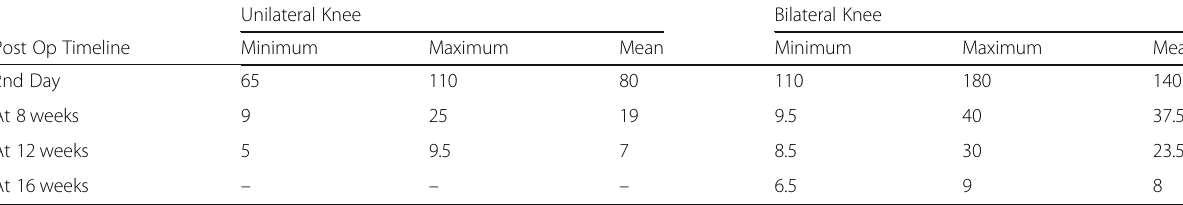
Table 4 CRP levels (mg/l) at various timelines